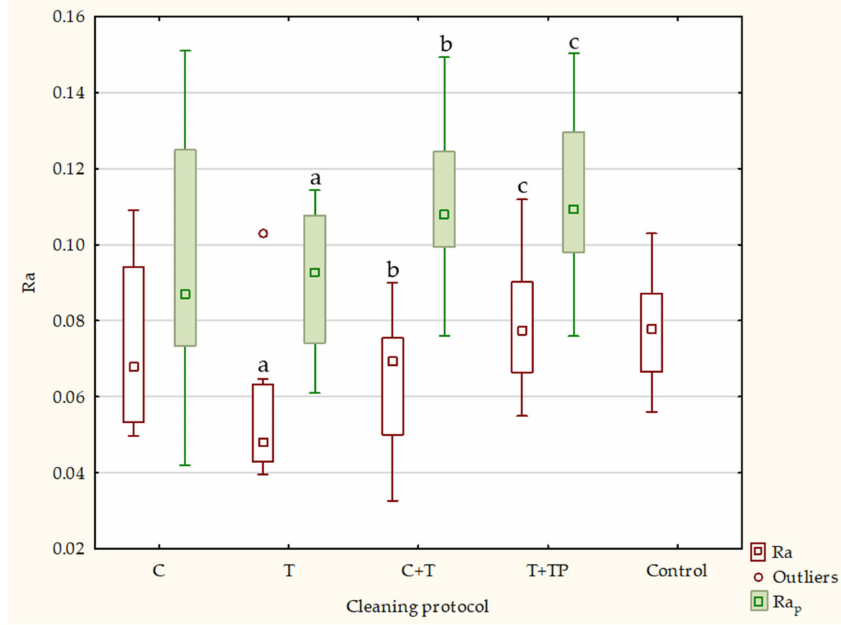
Figure 2. Surface roughness of the Erkodur-A1 top side in different cleaning protocols; median, box: 25–75%, whisker: non-outlier range; C—Corega, T—toothbrush, TP—toothpaste, Rap—surface